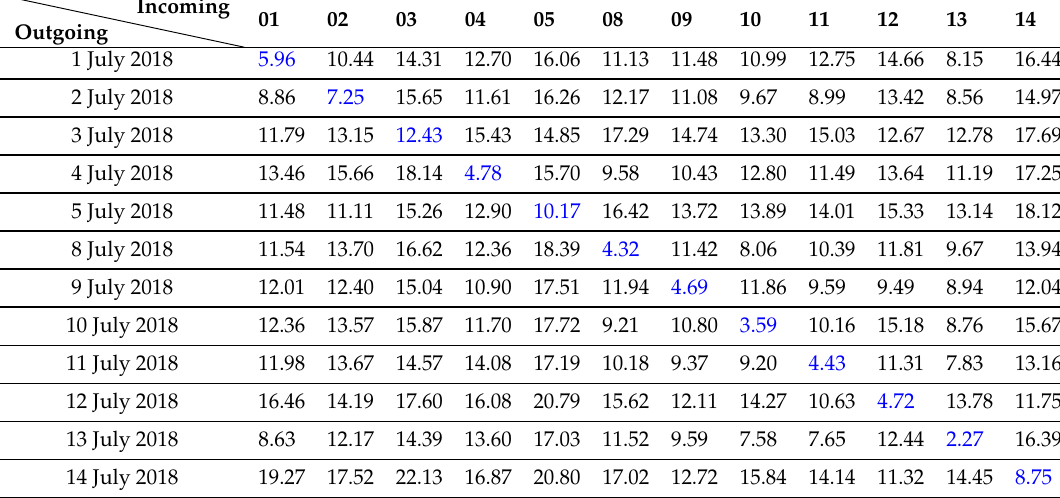
Table A4. DTW similarity scores between outgoing and incoming traffic curves for 1–5 July 2018 and 8–14 July 2018; the diagonal values are marked in blue to signify that that particular DTW value is the lowest in the investigating row. The statistics of the blue diagonal values (same day) are: median = 4.75, µ = 6.1, and σ = 2.85; and the statistics for the other 132 non-diagonal values (different days) are: median = 13.145, µ = 13.28, σ =